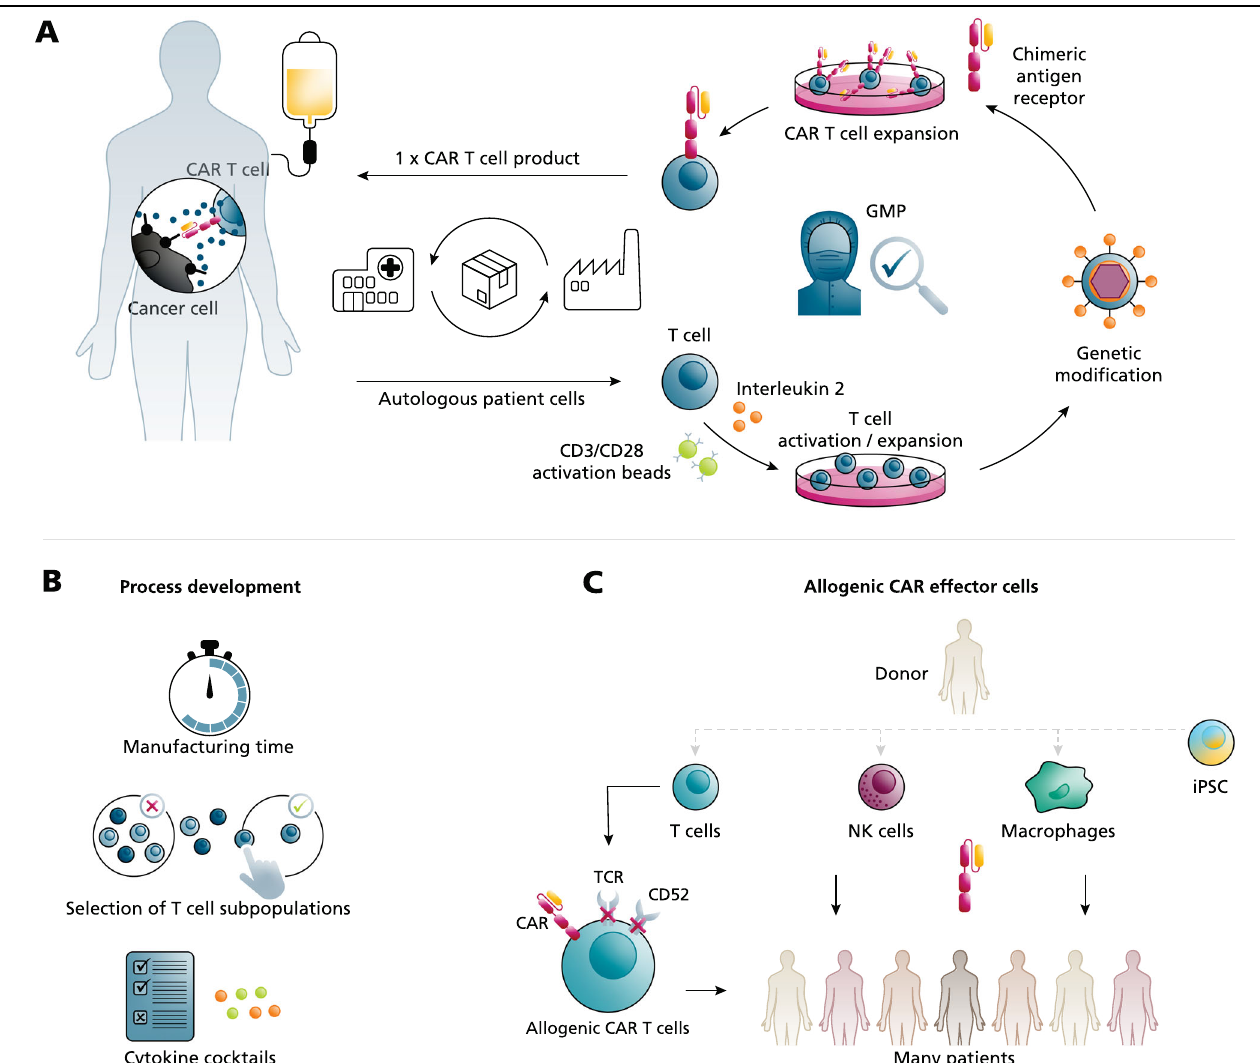
Fig. 1 | Manufacturing ofCAR T cellsand biologicalapproaches to increasethe availabilityofCARimmunotherapies.A Currentlyapprovedautologouschimeric antigen receptor (CAR) T cell immunotherapy is based on a person ’ s own T cells that are given back to the same patient after ex vivo modi fi cation. The production process is performed under Good Manufacturing Practice (GMP) conditions and monitored by several quality controls. B Biological approaches to increase CAR T cell quality by process development include the reduction of the manufacturing time,theselectionof ef fi cientTcellorCARTcellsubpopulationsandthe